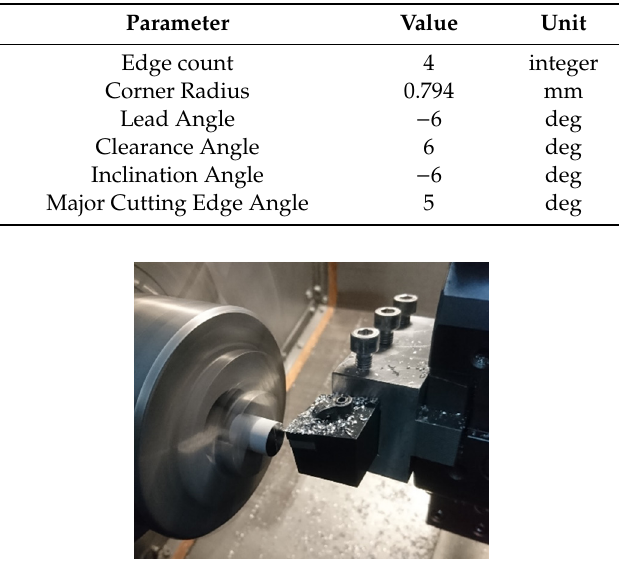
Figure 1. Face cutting process of a CoCr alloy sample on an AFM TAE 35 lathe.